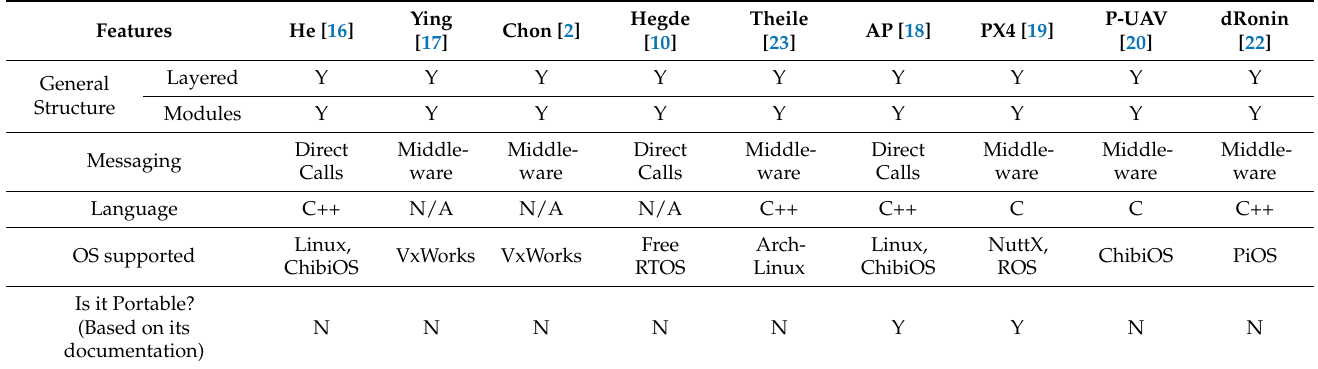
Table 1. Comparison of the flight control software and its